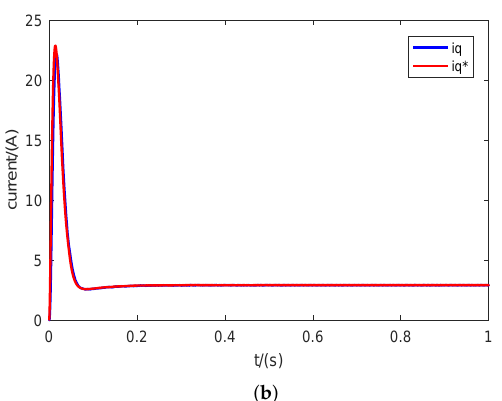
Figure 8. Simulation results with deadbeat control method under the parameter disturbance: ( a ) d-axes current and ( b ) q-axes current.